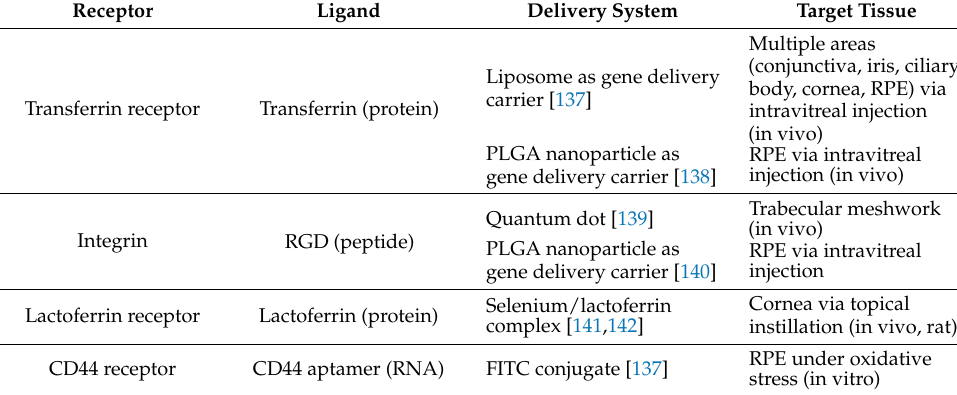
Table 1. Various receptor-specific ligands to target specific ocular tissues. Receptor Ligand Delivery